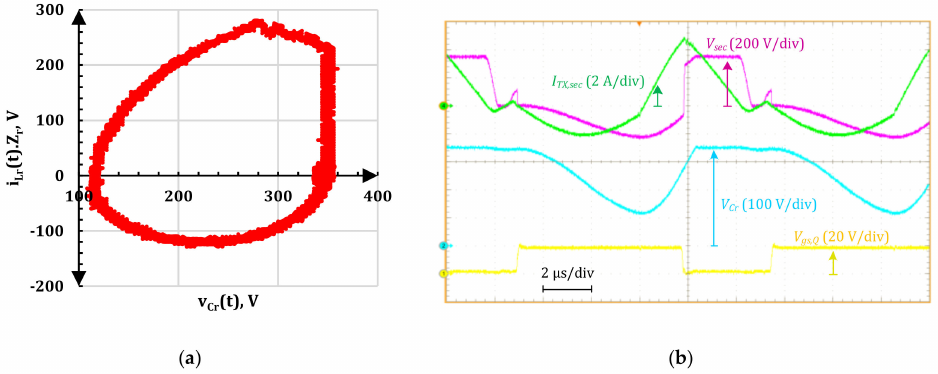
Figure 19. Experimental waveform of the proposed converter for scenario B: ( a ) Trajectory curve and ( b ) steady-state waveforms.